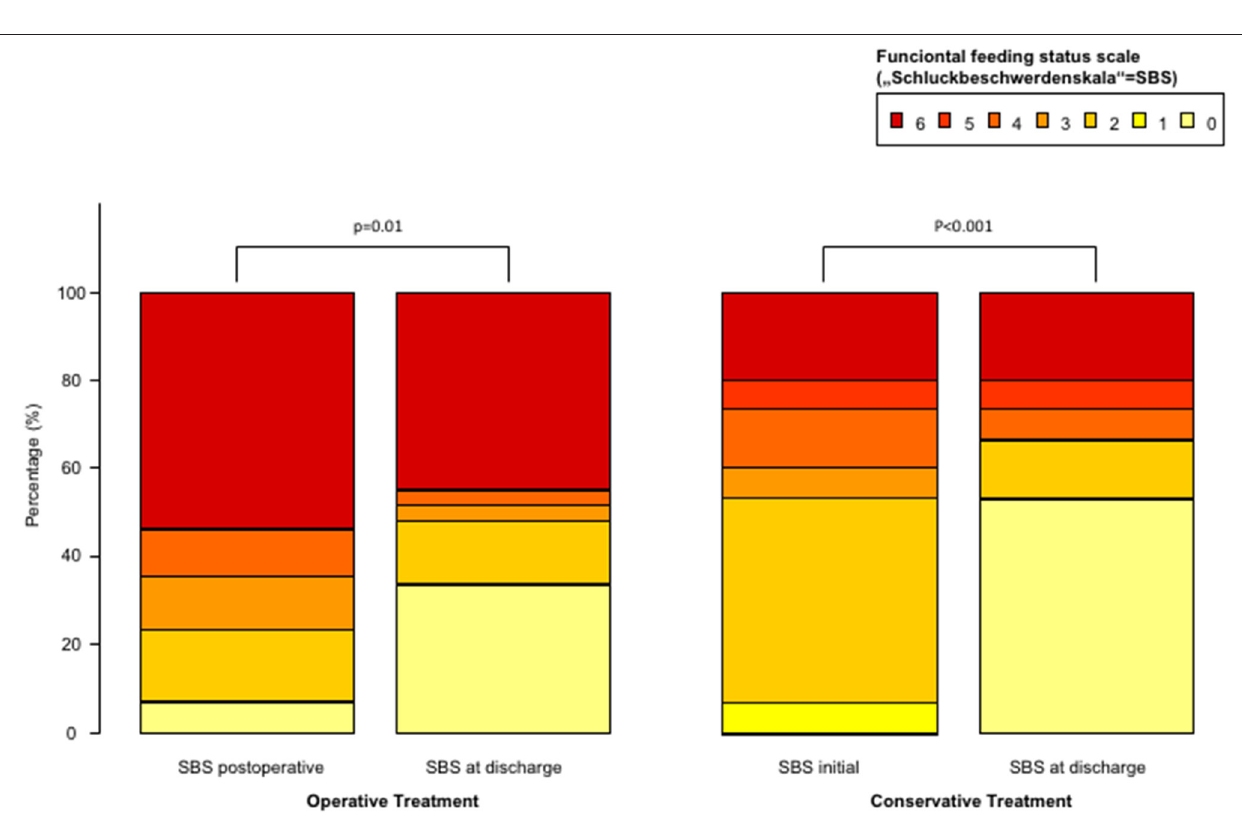
best of our knowledge, the first systematic investigation on dysphagia in patients suffering from acute and chronic